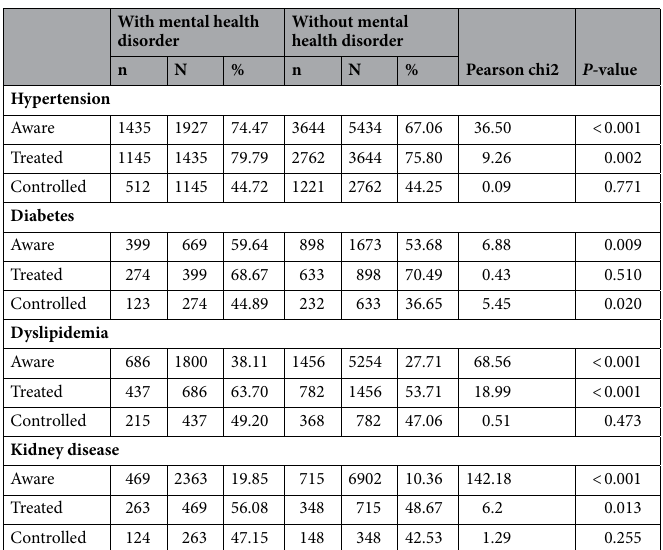
Table 2. Prevalence of NCD aware, treated, and controlled for people with and without mental health disorder. n: number of people in this group; N: total number of people in this group. P < 0.01, P < 0.05, P < 0.1. This table compare the significance in the difference of NCD awareness, treatment, and control for people with and without mental health disorders. Chi-square test is used to test the significance in